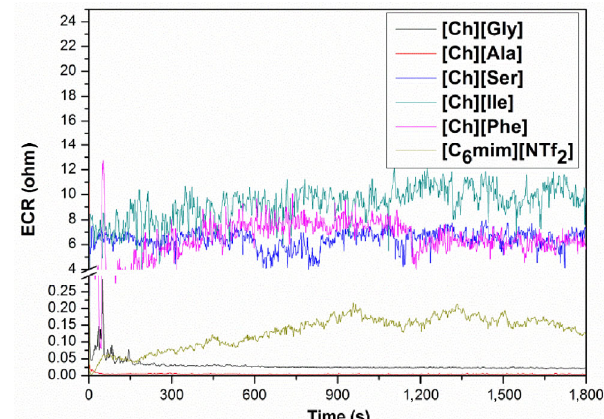
Fig. 6 Contact resistance of [Ch][AA] ILs and [C 6 mim][NTf 2 ] recorded using the SRV tester.